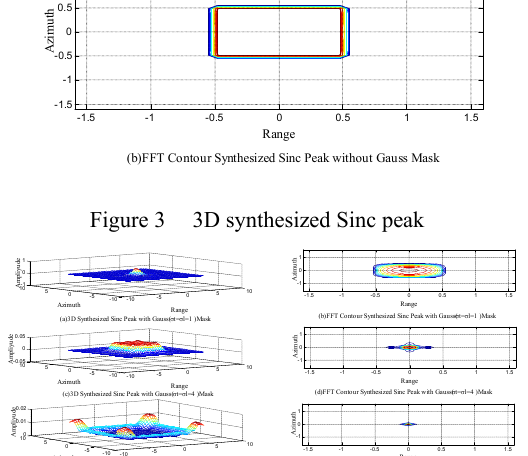
)MaskRange (f)FFT Contour Synthesized Sinc Peak with Gauss(  t=  l=13